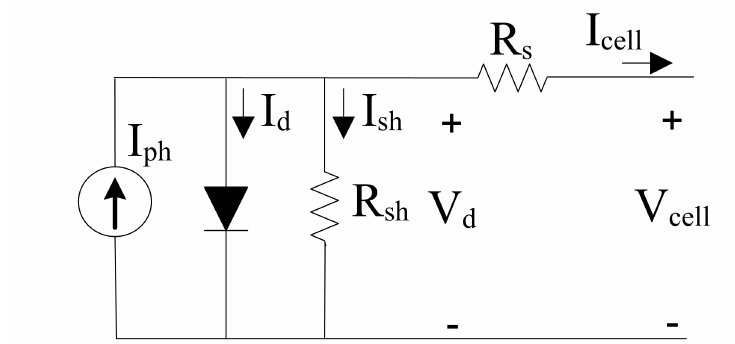
Figure 2. Circuit diagram of the Single Diode Model.